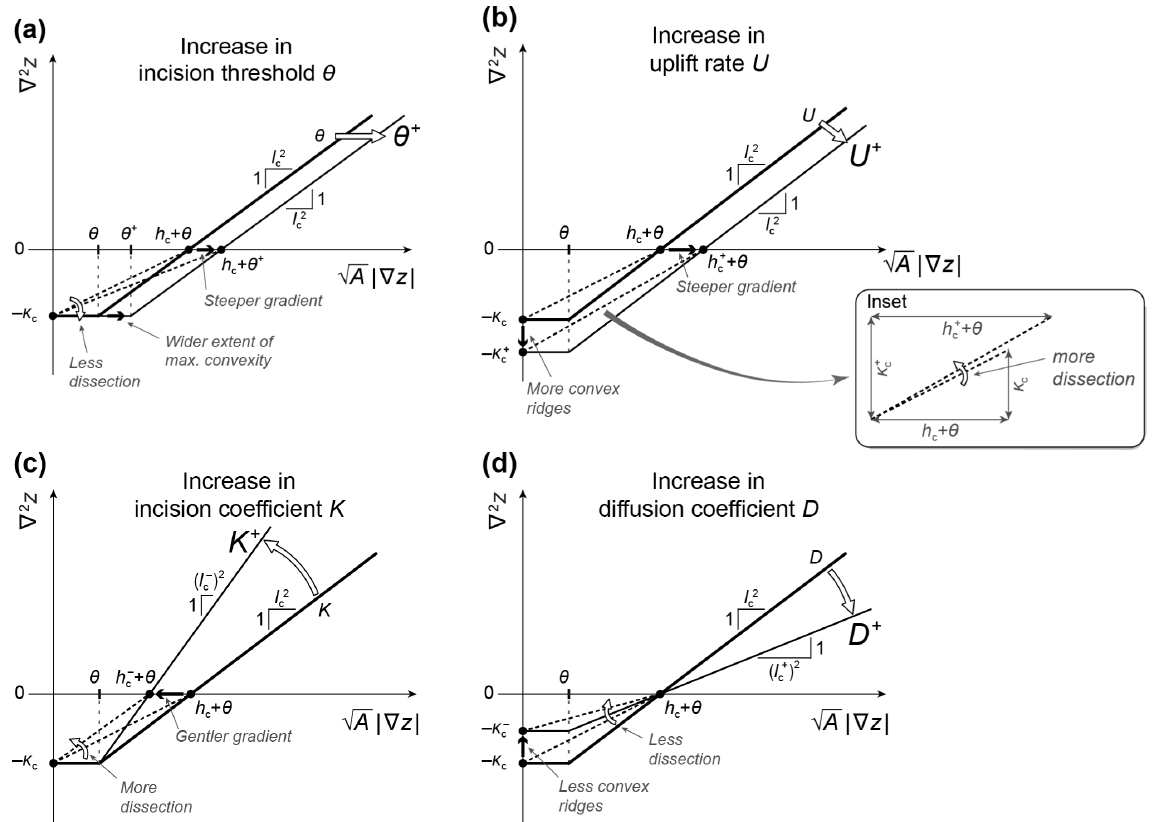
Figure 4. Graphical illustration, using curvature–steepness index lines, of how an incision threshold and parameters control landscape properties. The four plots show how curvature–steepness index lines respond to increases in the incision threshold θ , uplift rate U , incision coefficient K , and diffusion coefficient D . (a) An increase in the incision threshold θ parallel-shifts the line to the right. Note the difference with the shift in (b) , which is to the right and downward. The shift in (a) makes the horizontal segment of the line longer and the horizontal- axis intercept bigger, showing that the zones of maximum convexity become wider, gradients become steeper, and drainage areas of valley heads become larger. The curvature value of the horizontal segments and the line’s slope remain unchanged. The increase in the horizontal- axis intercept changes its ratio to the vertical-axis intercept, which expresses the degree of landscape dissection as explained in Sect. 3.3. This ratio can be visualized by the dashed auxiliary lines that connect the horizontal- and vertical-axis intercepts, and the change in the value of the ratio can be visualized by the rotation of these lines. (b) An increase in the uplift rate U shifts the line to the right and downward. This makes the vertical-axis intercept smaller (more negative) and the horizontal-axis intercept bigger, showing that ridges become more convex and that gradients become steeper (i.e., relief becomes higher). The changes in these two intercepts are not proportional and thus their ratio changes. This change can be visualized in the inset, where we plot the auxiliary lines such that they share the same starting point. This shows that the degree of landscape dissection changes when U is increased, whereas it did not change in the case of the LEM without an incision threshold (see Fig. 3). (c) An increase in the incision coefficient K rotates the inclined segment of the line counterclockwise around its intersection with the horizontal segment. The horizontal segment remains unchanged. Thus, the horizontal-axis intercept becomes smaller, which shows that gradients become gentler and the landscape becomes more dissected. (d) An increase in the diffusion coefficient D rotates the inclined segment line clockwise around the horizontal-axis intercept. This moves the horizontal segment and the vertical-axis intercept closer to zero and changes the ratio of the two intercepts, showing that ridges become less convex and that the landscape becomes less